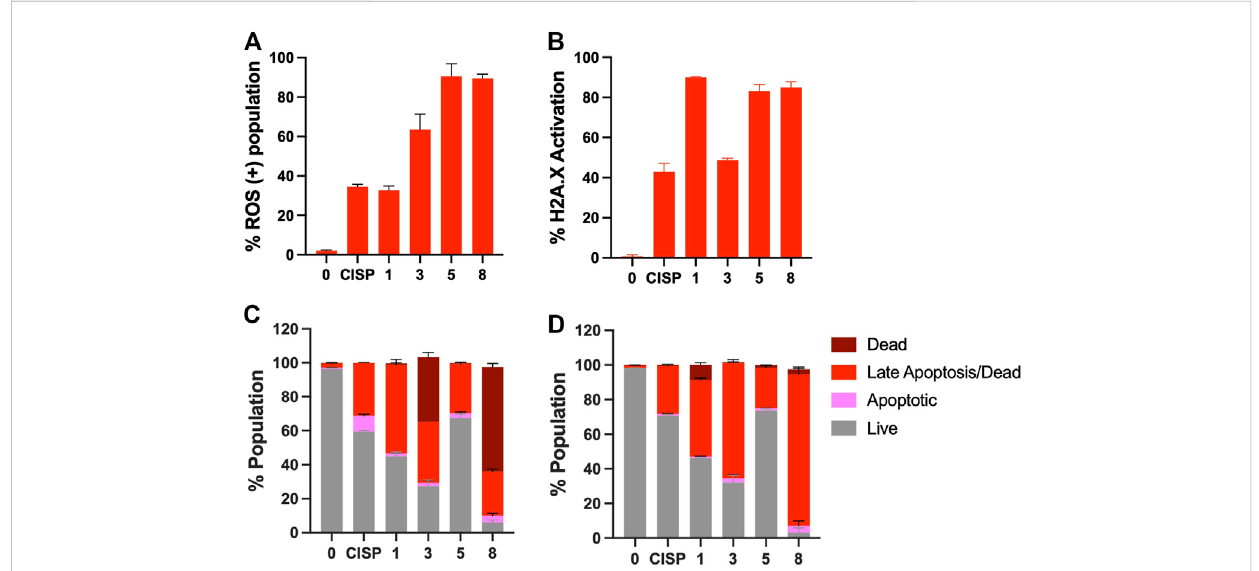
FIGURE 7 Induction of oxidative stress and DNA double strand breaks upon treatment with Cu(II) complexes. (A) A-375 cells were treated with cisplatin (CISP) or 1 , 3 , 5 , 8 and assessed for ROS activation via dihydroethidium staining. (B) A-375 cells were stained with antiphospho-Histone H2A.X (Ser139), Alexa Fluor ® 555 and anti-Histone H2A.X, PECy5 conjugated antibodies, following cisplatin or 1 , 3 , 5 , 8 treatment. The cells were scored using Muse Cell Analyzer. Induction of apoptosis upon treatment with the Cu-complexes. Flow cytometric analyses of (C) Annexin V/7-AAD positivity and (D) Caspase 3/7 activity on A-375 cells. Cells were exposed to 1, 3, 5 and 8 or cisplatin at half inhibitory concentrations for 48 h and counted with Muse Cell Analyzer.